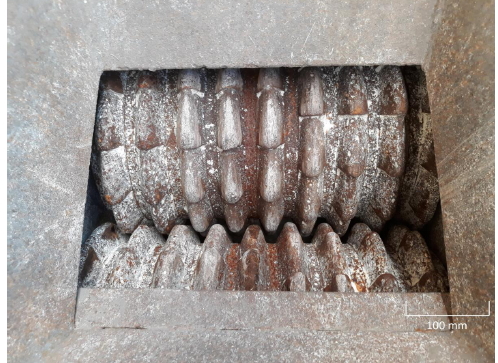
Figure 4. Inside view of the toothed roll crusher.